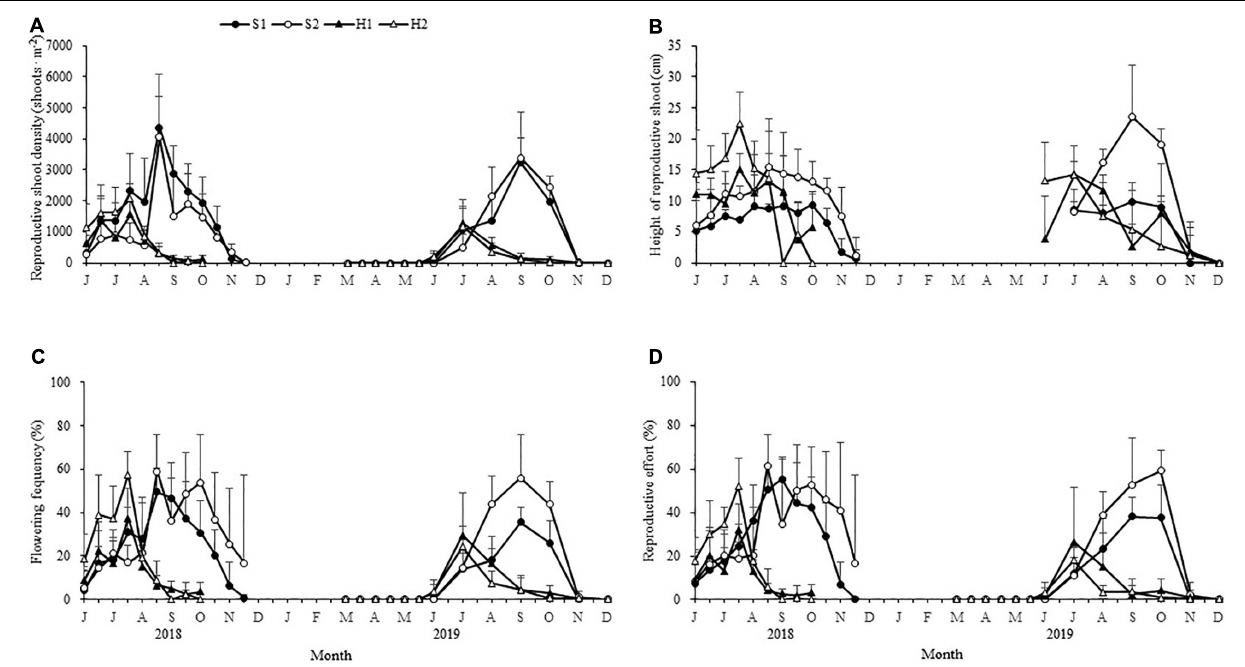
FIGURE 5 | Seasonal changes in the reproductive shoot densities (A) , reproductive shoot height (B) , flowering frequency (C) , and reproductive effort (D) of Zostera japonica at the four study sites from June 2018 to December 2019. Values are mean ± SD ( N = 7 cores per site). TABLE 2 | Flowering traits of Zostera japonica at the four study sites from June 2018 to December 2019. Variable S1 S2